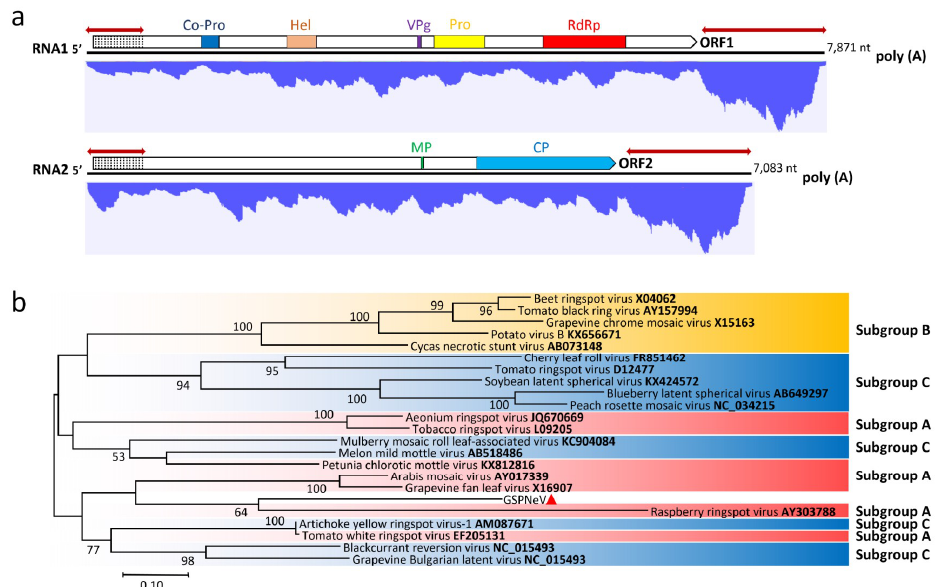
Figure 2. ( a ) Genomic structure of green Sichuan pepper-nepovirus (GSPNeV) and